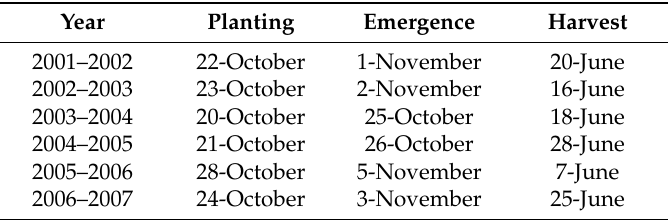
Table 1. Wheat planting, emergence, and harvesting date from 2001 to